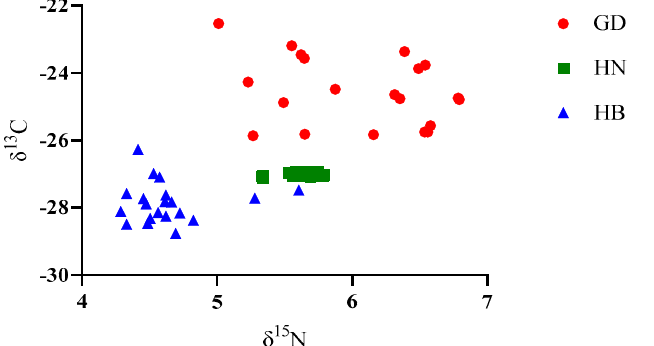
Figure 1. Scatter plot based on δ 13 C and δ 15 N of 60 samples. GD = Guangdong; HN = Hunan; HB = Hubei. δ 13 C and δ 15 N represent the stable isotope ratios.